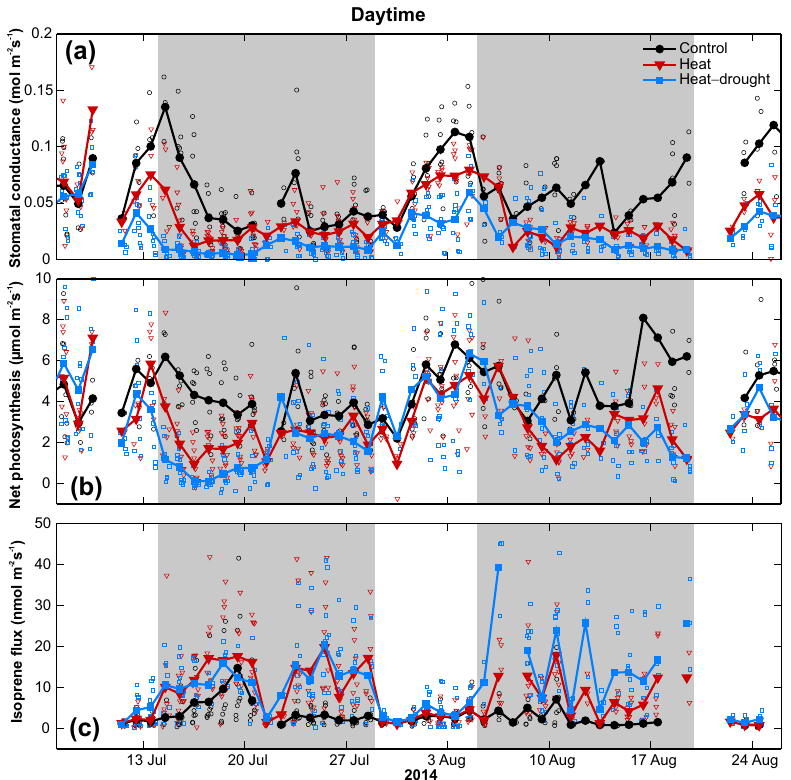
Figure 3. Daytime (PAR>50µmolm − 2 s − 1 ) values for stomatal conductance (a) photosynthesis (b) and isoprene emission (c) of black locust trees for the control (black circles), heat (red triangles) and combined heat–drought treatment (blue squares). Filled symbols and lines are daytime averages which on average consist of seven single chamber measurements. Heatwaves are represented by the grey colored areas.